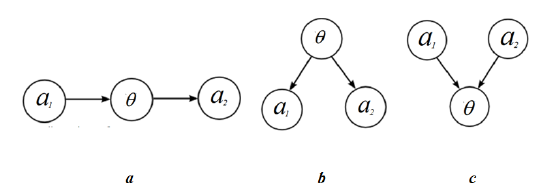
Figure 2: Subgraphs of the probability connections. pointers on the graph edges are suspended in most of the cases of this